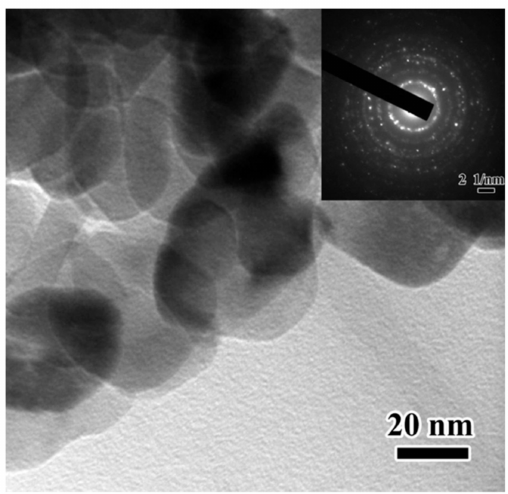
Figure 14. TEM image of the morphology of the TiO 2 nanoparticles and their selected area electron di ff raction(SAED).Reprintedwithpermissionfrom[100]. Copyright © 2013, AmericanChemicalSociety.